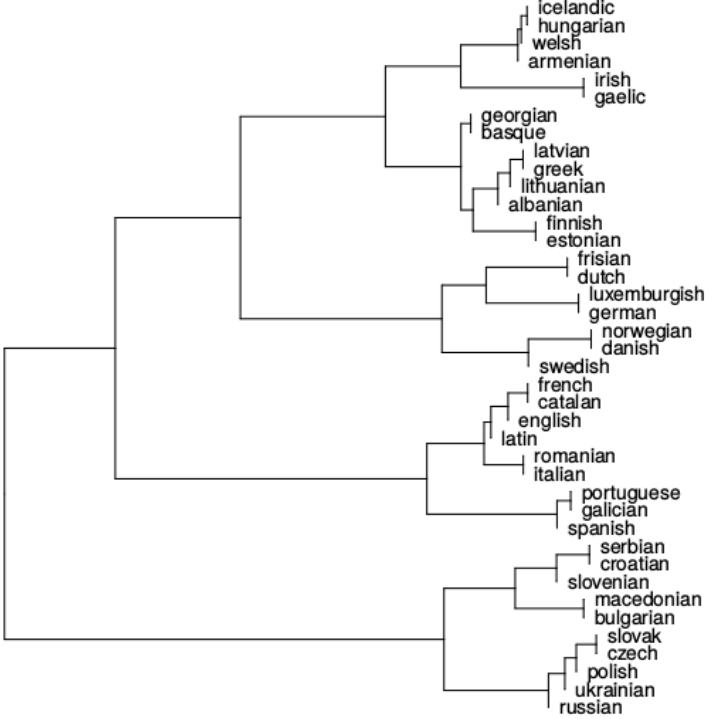
Figure 2. Clusters of all languages, including the isolated ones. Stylo configuration: Delta-Eder distance, Ward’s method, 3-grams of characters, and 1000 most frequent